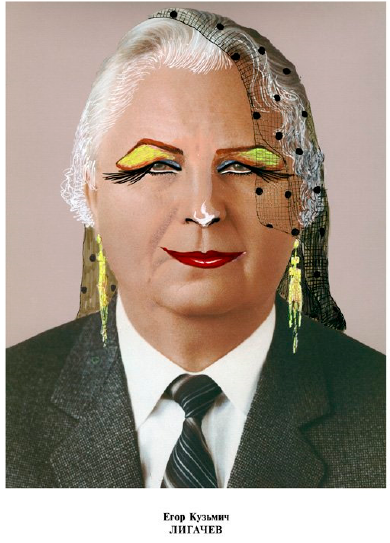
Figure 2. Vlad Mamyshev-Monroe. From the series “Politburo” (1995) E.K. Ligachev. https://vmmf.org/series/view?id=4#work-series-4-5 (accessed on 11 September 2022).